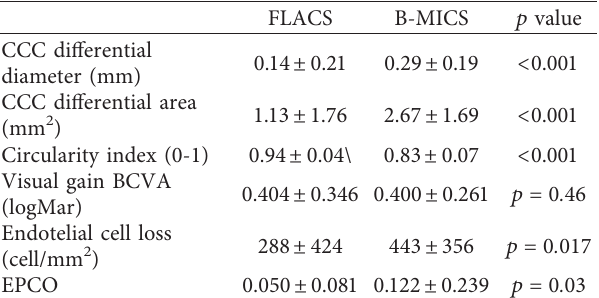
Figure 4: Box plot with whiskers indicating 95% confidence intervals for EPCO score variation in an 18-month follow-up period. Table 4: Summary of study findings at 18 months with statistical significance of the